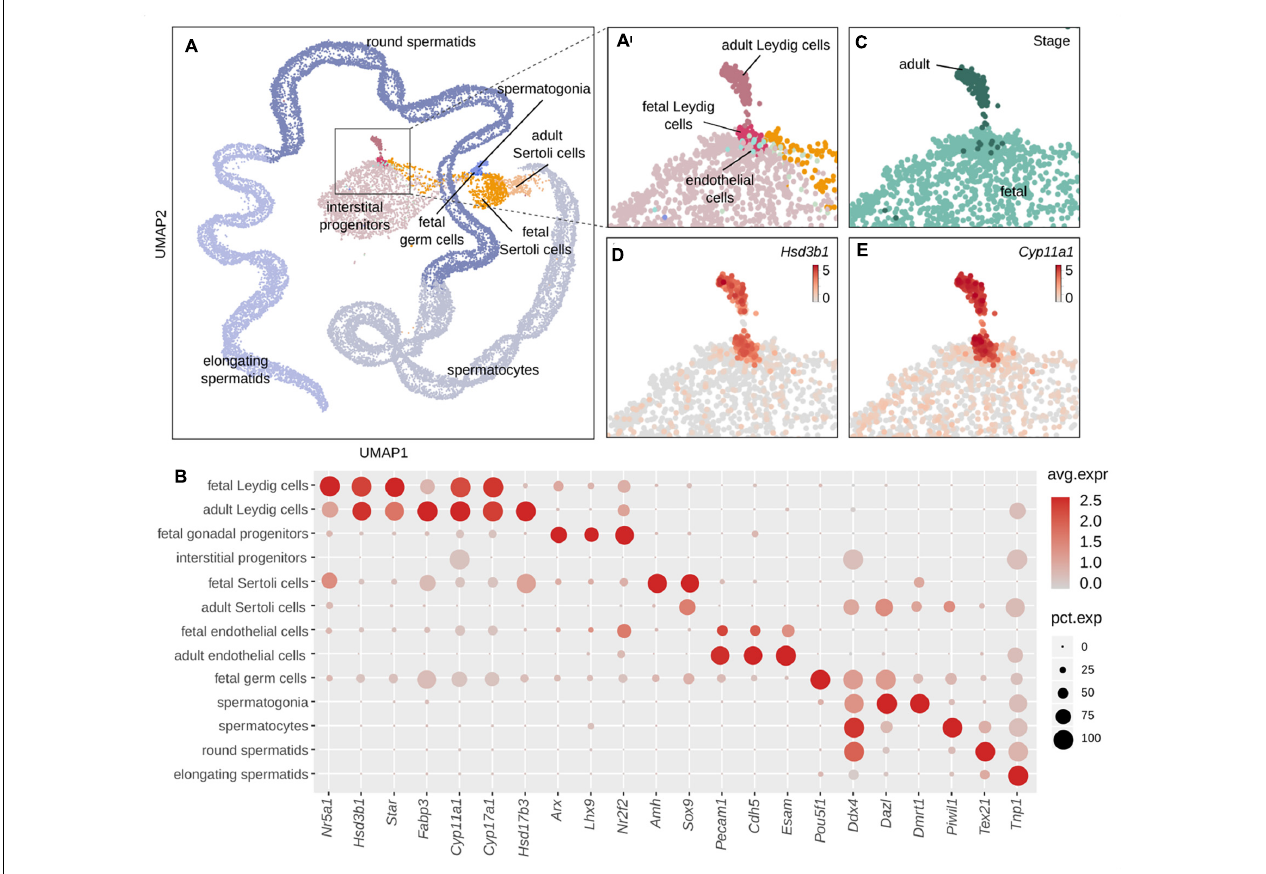
FIGURE 3 | Classification of cell populations in single-cell RNA sequencing data of fetal and adult mouse testis. (A) UMAP representation of single-cell transcriptomes colored by cell type, where each dot corresponds to one cell. Enlargement of the global UMAP on the area of interest which include both the fetal and adult Leydig, colored by cell populations (A (cid:48) ) and by developmental stage (C) . The fetal cells are colored in pale green and the adult cells in dark green. (D,E) Enlargement on the UMAP representation colored according to the normalized expression of Leydig cells marker genes Hsd3b1 (D) and Cyp11a1 (E) . (B) Dotplot displaying the expression of selected marker genes of testis cell populations. The size of the dots is proportional to the fraction of cells in the population expressing the gene and the scaled gene expression level is indicated by the color scale. Leydig cells: Nr5a1, Star, Cyp11a1. Sertoli cells: Hsd17b3, Amhg , and Sox9. Interstitial progenitors: Arx, Lhx9 , and Nr2f2. Endothelial cells: Pecam1, Cdh5 , and Esam. Germ cells: Pou5f1, Dddx4. Spermatogonia: Dmrt1. Spermatocytes: Piwil1. Round spermatids: Tex21. Elongating spermatids: Tnp1